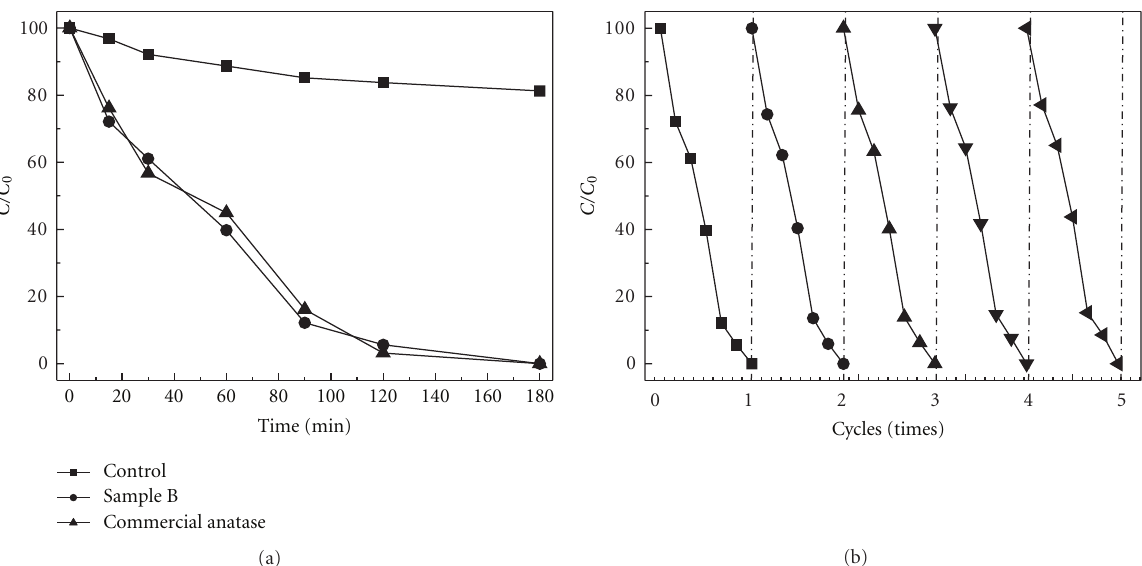
Figure 8: Photocatalytic e ffi ciency of commercial anatase TiO 2 and Sample B to methylene blue (MB); (b) the long-term photocatalytic activity of Sample